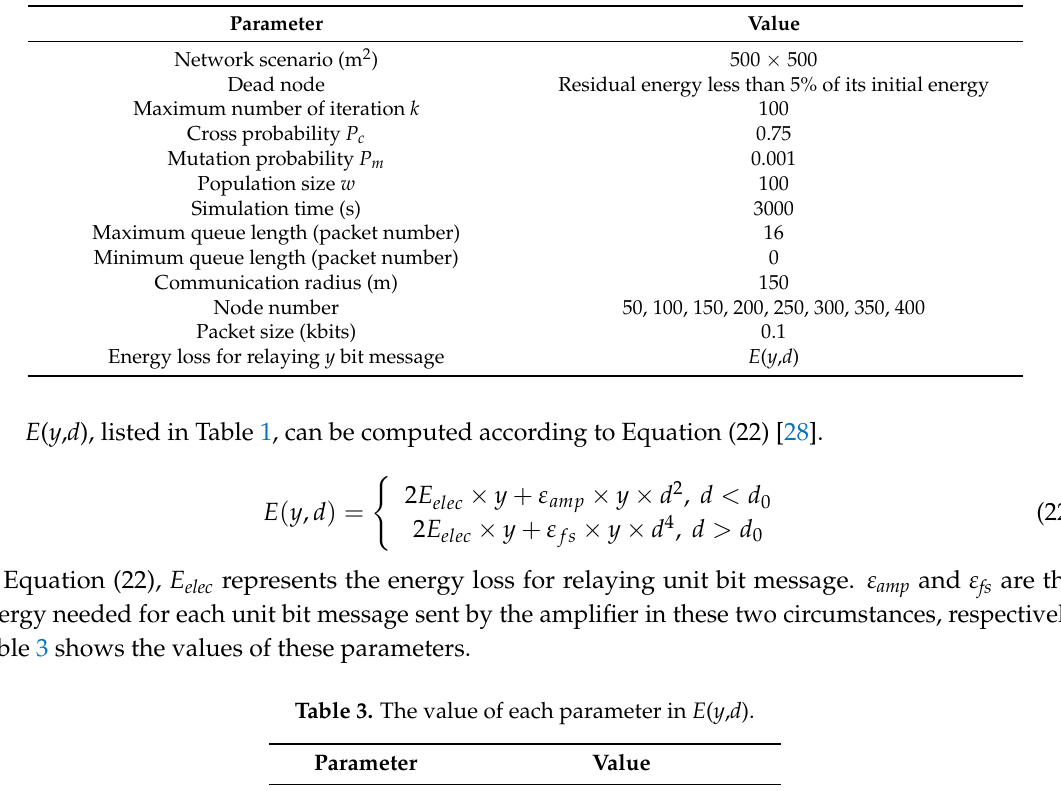
Table 2. Experiment parameters.